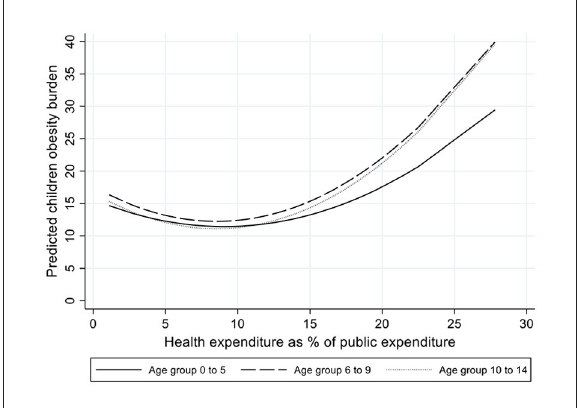
FIGURE1 Predicted children obesity burden by level of health expenditure as percentage of public